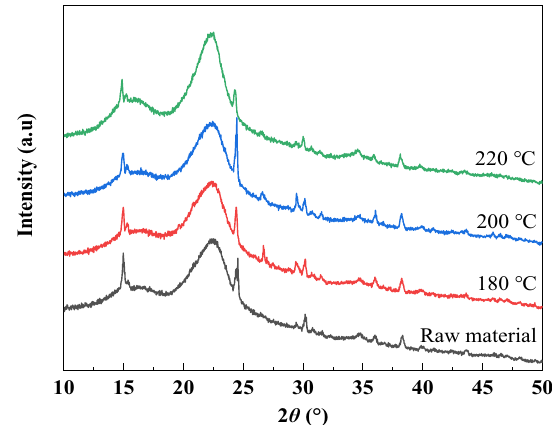
Fig. 10 XRD of raw material and binderless boards of Broussonetia papyrifera at different temperatures